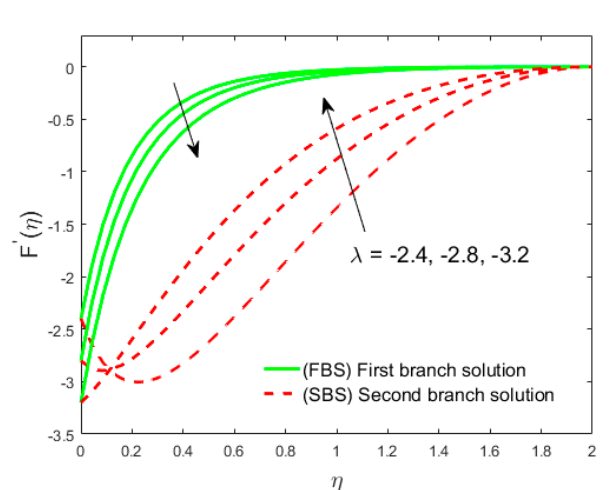
Figure 7. The impact of φ on F (cid:48) ( η ) .